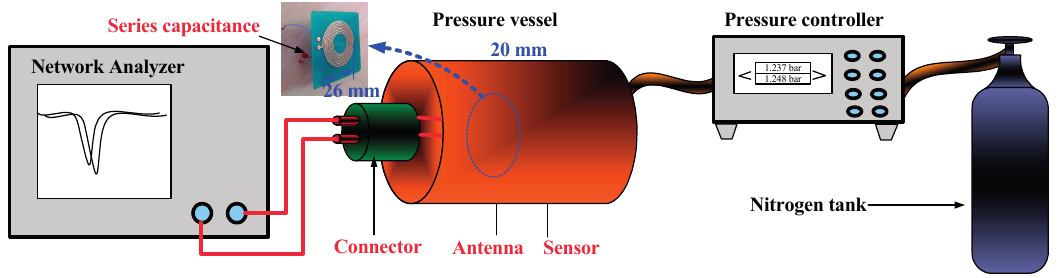
Figure 7. Sensor test setup for pressure